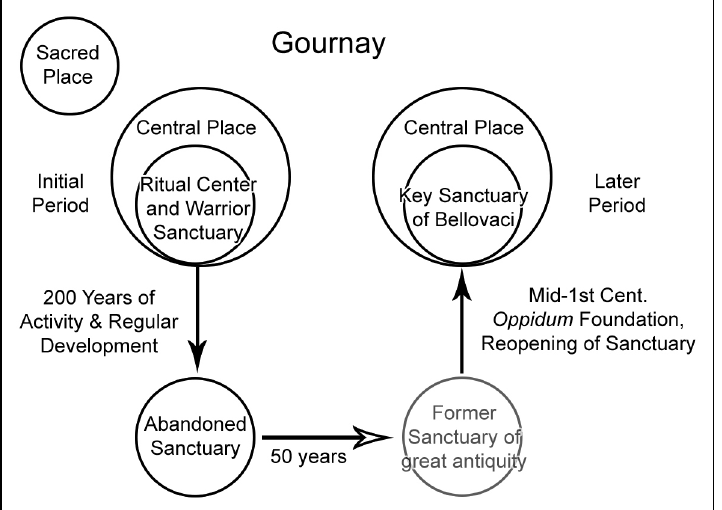
Figure 6: The theo- retical model applied to